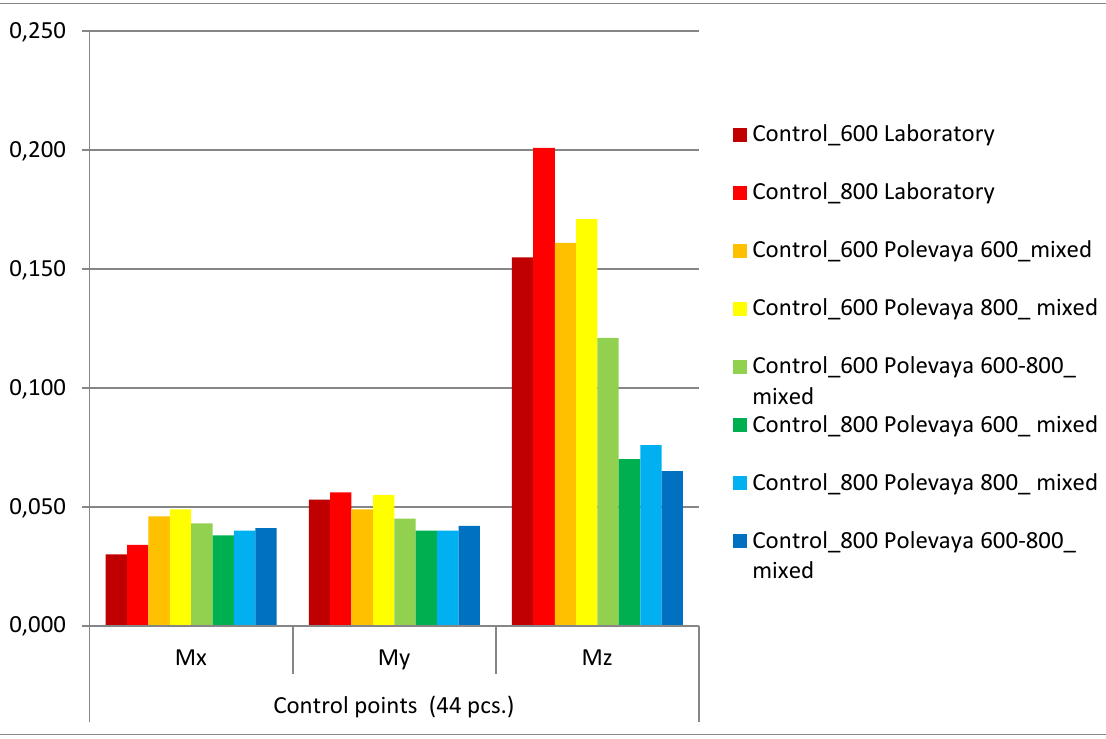
Figure 4. Estimation of accuracy of the triangulation on the basis of results of field calibration. PHOTOMOD (formula mixed